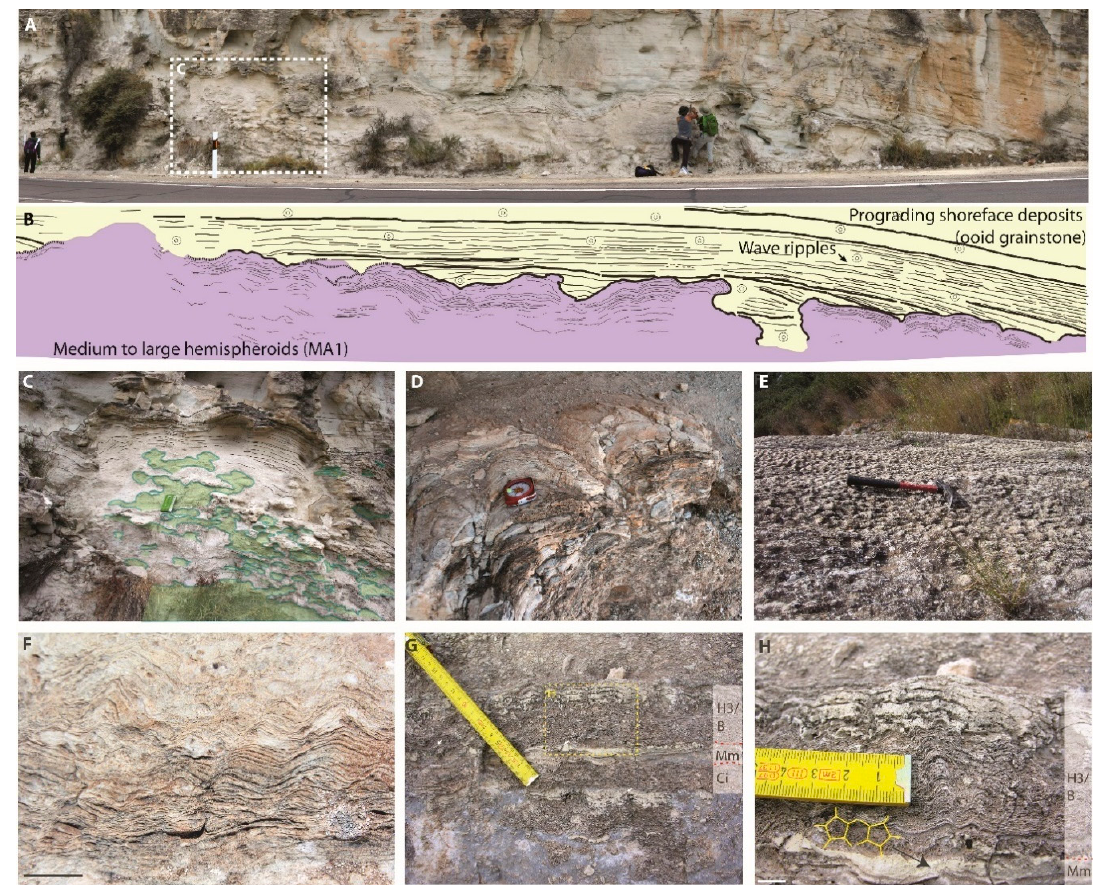
Figure 6. Macro- and mesofabrics of Microbialite Association 1 (MA1), from subtidal ( A – D ) to shallow subtidal / intertidal forms ( E – H ). ( A ) Photomosaic and ( B ) facies interpretation showing medium (H2) to large stromatolitic hemispheroids (H1). The stromatolite bed (purple) is eroded and onlapped by prograding shoreface to foreshore ooid grainstones (yellow). The locality of Sorbas, Depositional Sequence 3 (DS3). Persons for scale are 1.7 m tall. ( C ) Close-up view of ( A ), displaying rounded fluid circulation structures (green) inside a large hemispheroid stromatolite. ( D ) Oblique view of horizontally elongated medium hemispheroids. The compass for scale is 80 mm wide. Moras; DS4. ( E ) View of the surface of a bed covered by small circular hemispheroids (H3). The hammer is 40 cm long. Moras. ( F ) Small stromatolitic crinkles. Cariatiz, DS4. The scale bar is 2 cm. ( G ) Intertidal succession showing crinkles (C i ) and small hemispheroids alternating with micrite beds affected by mudcracks (Mm) indicating desiccation episodes. South of Santa Pola atoll. ( H ) Close-up view of ( G ). The hemispheroids locally show a knobby morphology.